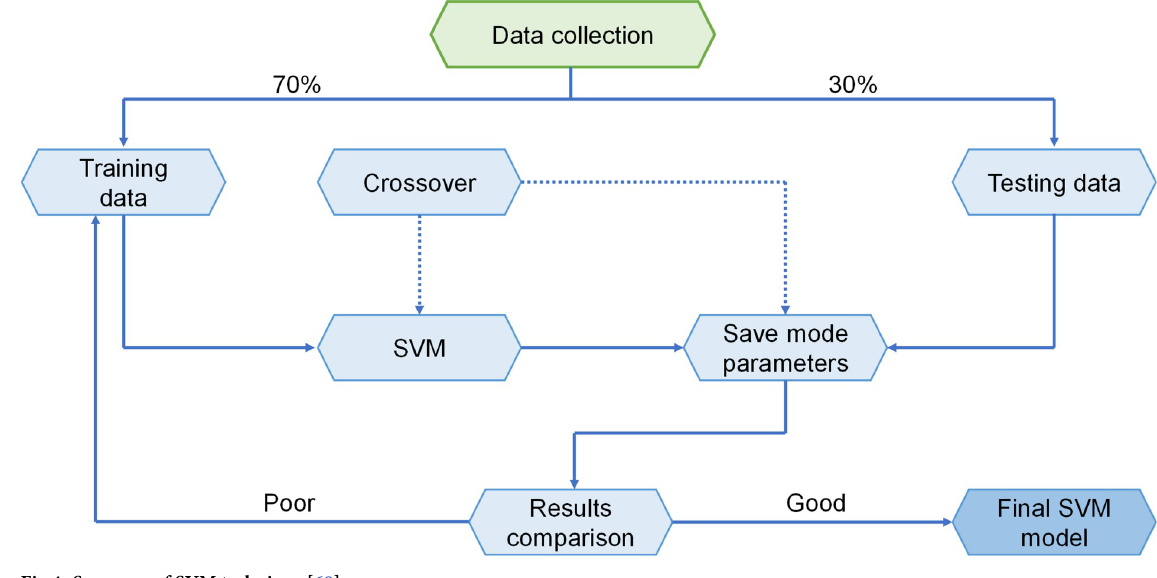
Fig 4. Sequence of SVM technique